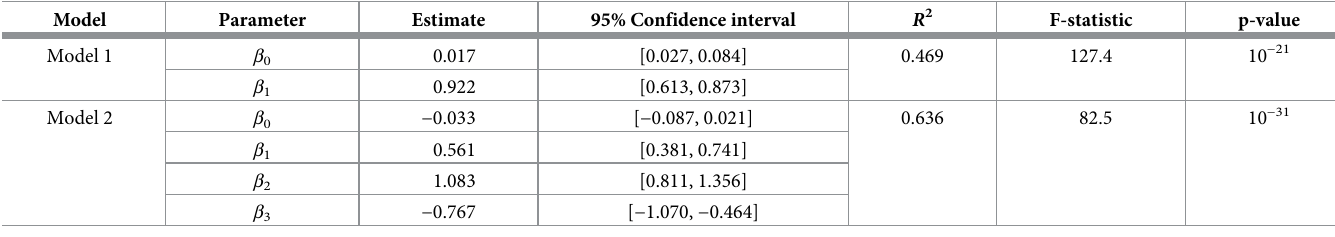
Table 2. Results of Models 1-2 with the statistics of model parameters and performance.